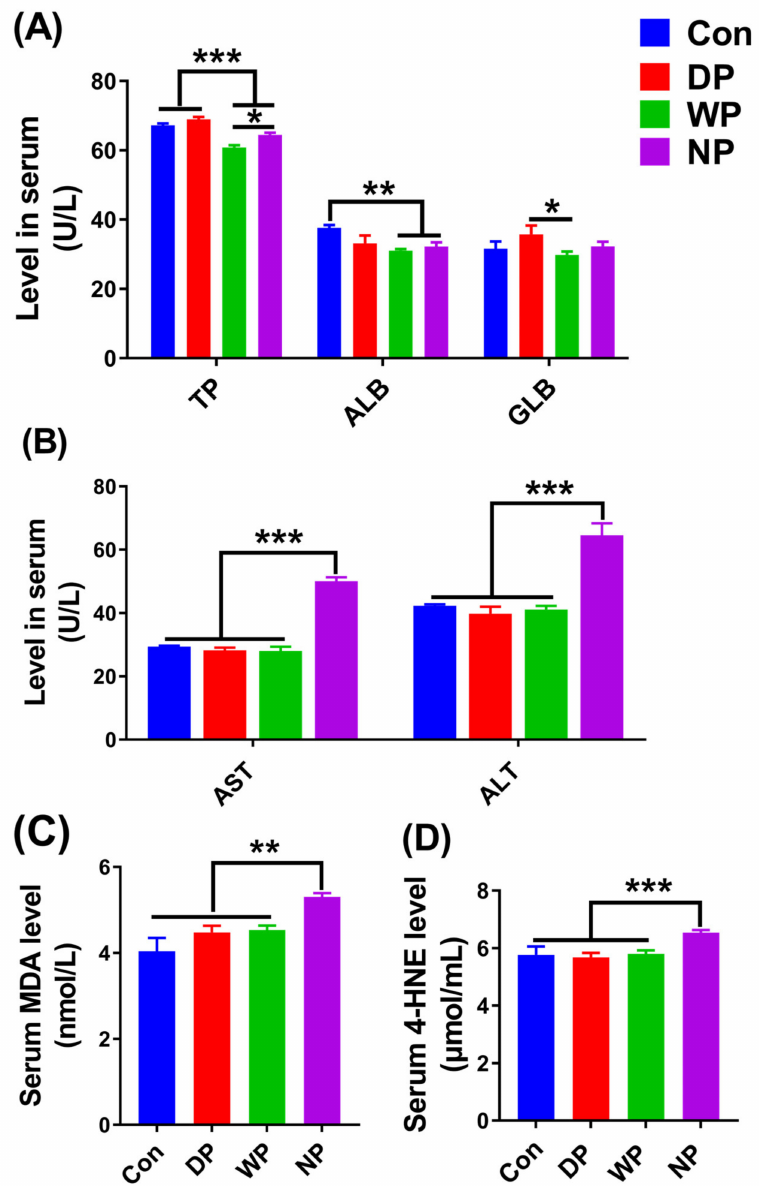
Figure 6. Biochemical indicators in serum on day 14 post-BMT. ( A ) Concentrations of albumin (ALB), globulin (GLB), and total protein (TP). ( B ) Concentrations of alanine aminotransferase (ALT) and aspartate aminotransferase (AST). ( C ) Concentrations of malondialdehyde (MDA). ( D ) 4-hydroxynonenal (4-HNE). Data are presented as mean ± SEM ( n = 5–7). Results are rep- resentative of at least two independent experiments. *** p < 0.001, ** p < 0.01, * p < 0.05. Per-conditioning, such as lethal irradiation treatment prior to BMT, can result in cell and tissue injury from oxidative stress [43,44], which may lead to delayed immune reconstitution and poor clinical outcomes. Body oxidative stress indicators MDA and 4-HNE, and liver injury indicators ALT and AST, can be used to detect cell and tissue injury. Thus, we gathered serum samples from day 14 post-BMT mice to measure the concentrations of those indicators. Interestingly, we found lower concentrations of ALT, AST, MDA, and 4-HNE in sera from the DP and WP groups compared with the NP group ( p < 0.01; Figure 6B–D). The contents of ALT, ASL, MDA and 4-HNE in the DP and WP groups were similar to those in the Con group, and there was no significant